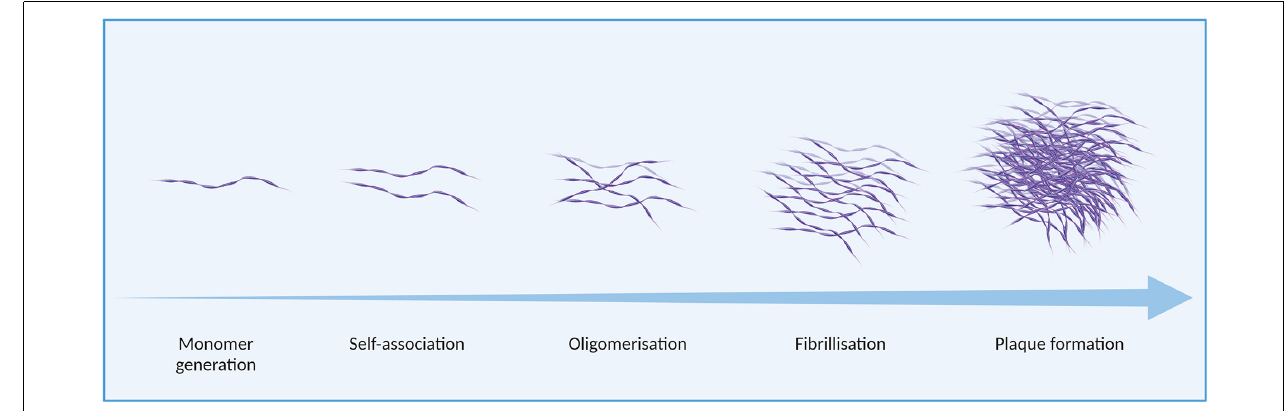
FIGURE 2 | Amyloid-beta aggregation in Alzheimer’s disease